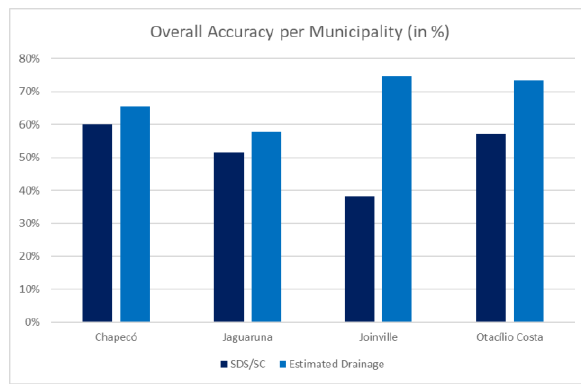
Figure 5 – Overall Accuracy per Municipality (in %).